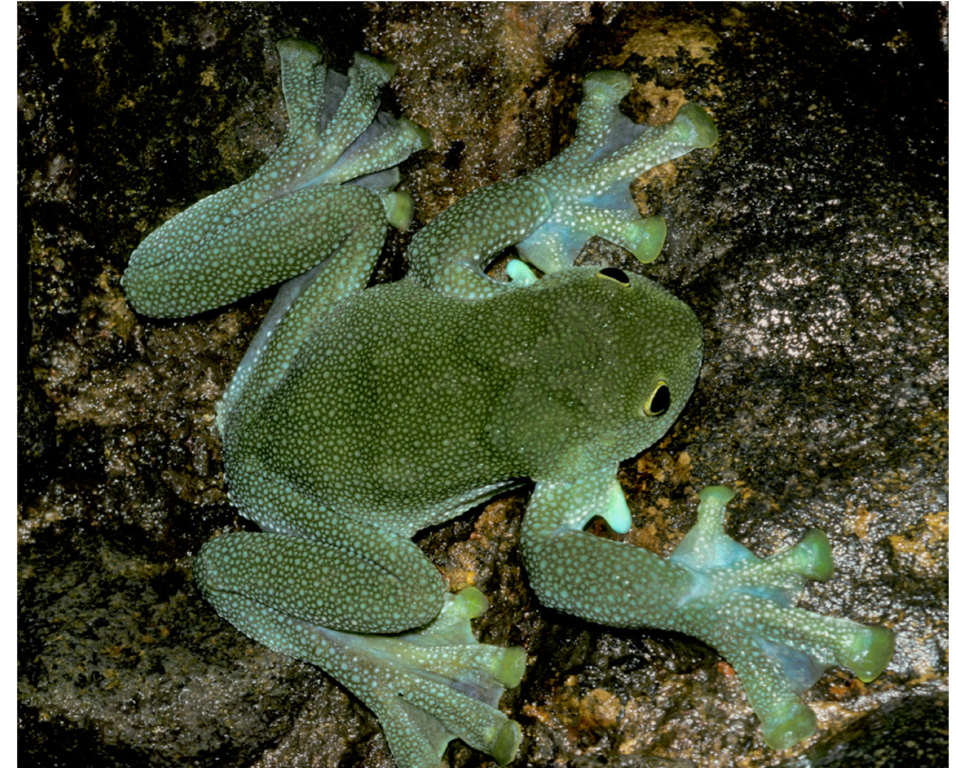
Figure 34. Centrolene geckoidea in life. Ecuador, Carchi province, R í o La Plata (00 ◦ 48 (cid:48) N, 78 ◦ 02 (cid:48) W; 2525 m), on the Maldonado–Tulc á n road, DHMECN 0900. Photo by Doug Wechsler (25 July 1988). Diagnosis: (1) Each vomer with four or five teeth; (2) snout truncated in dorsal and lateral profiles (Figure 35); (3) tympanum visible and small, oriented almost vertically, its diameter 40.3%–50.0% of eye diameter; supratympanic fold moderate; tympanic membrane completely pigmented, di ff